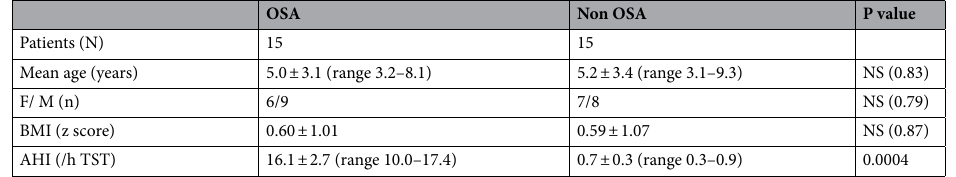
Table 1. Antropometric and polysomnographic main charachteristics of the 15 OSA and 15 non OSA pt. AHI Apnea Hypopnea Index, TST total sleep time, NS not